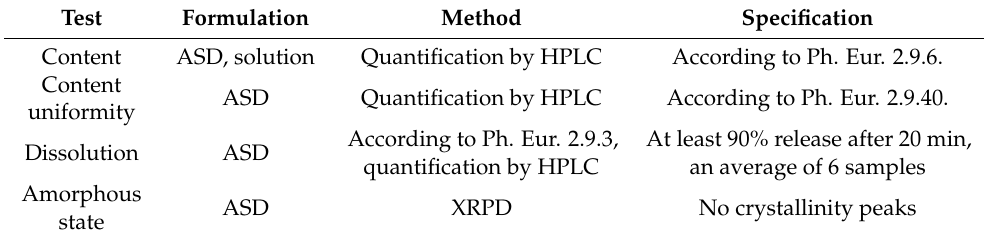
Table A3. ASD formulation